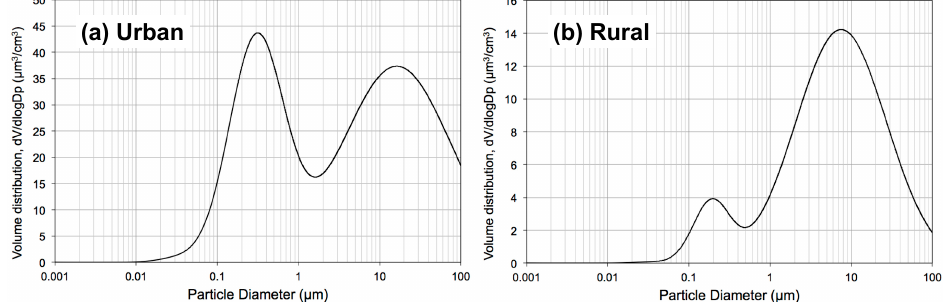
Figure 1. Volume distribution functions recreated from the trimodal ( a ) urban and ( b ) rural ambient aerosol distributions reported in Seinfeld and Pandis (2006) [30] and Jaenicke (1993) [31]. Table 1. Total number concentrations, geometric mean diameters, and geometric standard deviations for the trimodal ambient aerosol distributions from Jaenicke (1993) [31] and used in ISO 18690 [9].